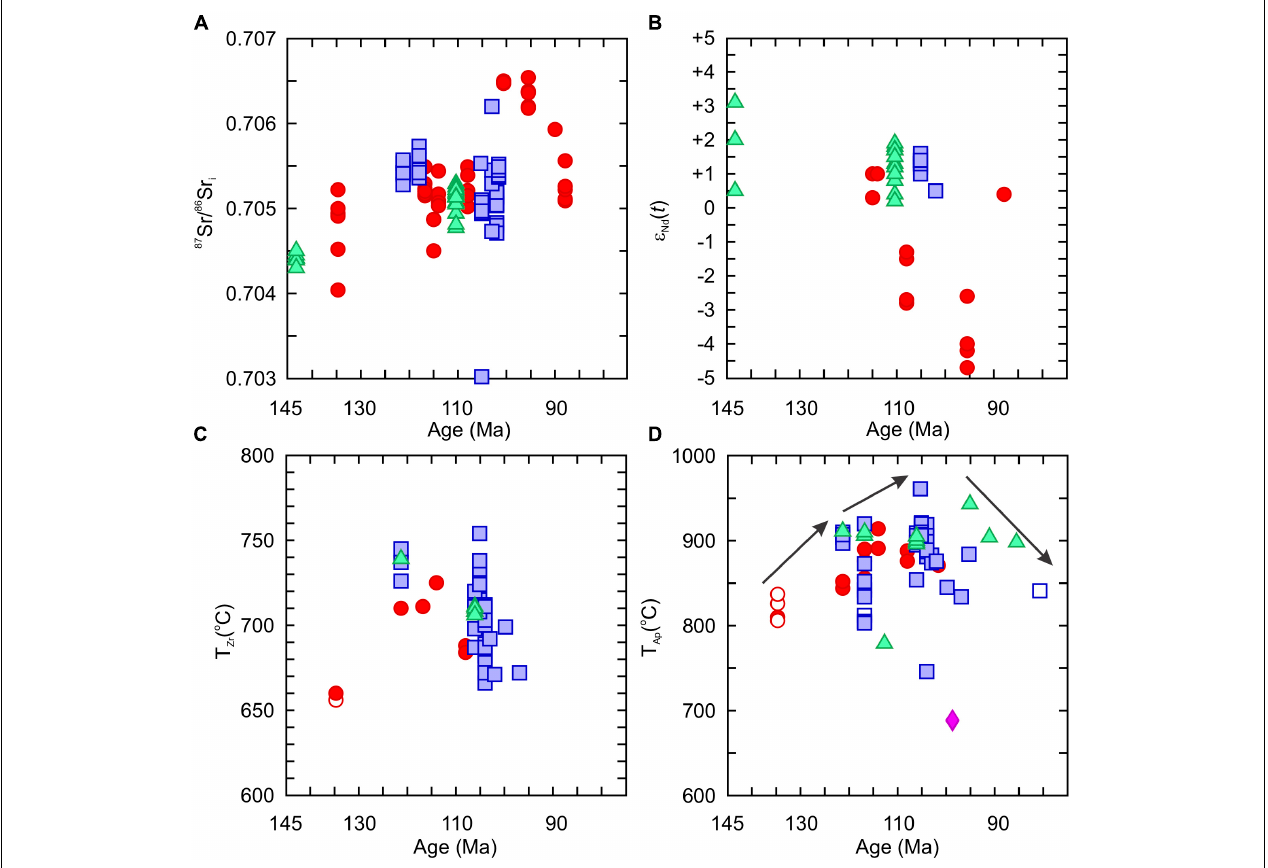
FIGURE 9 | Secular variation of (A) 87 Sr/ 86 Sr i , (B) ε Nd ( t ), (C) zircon saturation temperature ( T Zrc ◦ C), and (D) apatite saturation temperature ( T Apt ◦ C) in the Cretaceous granitic (granties, granodiorites, tonalites, diorites) rocks from Kyushu. Symbols as in Figure 2